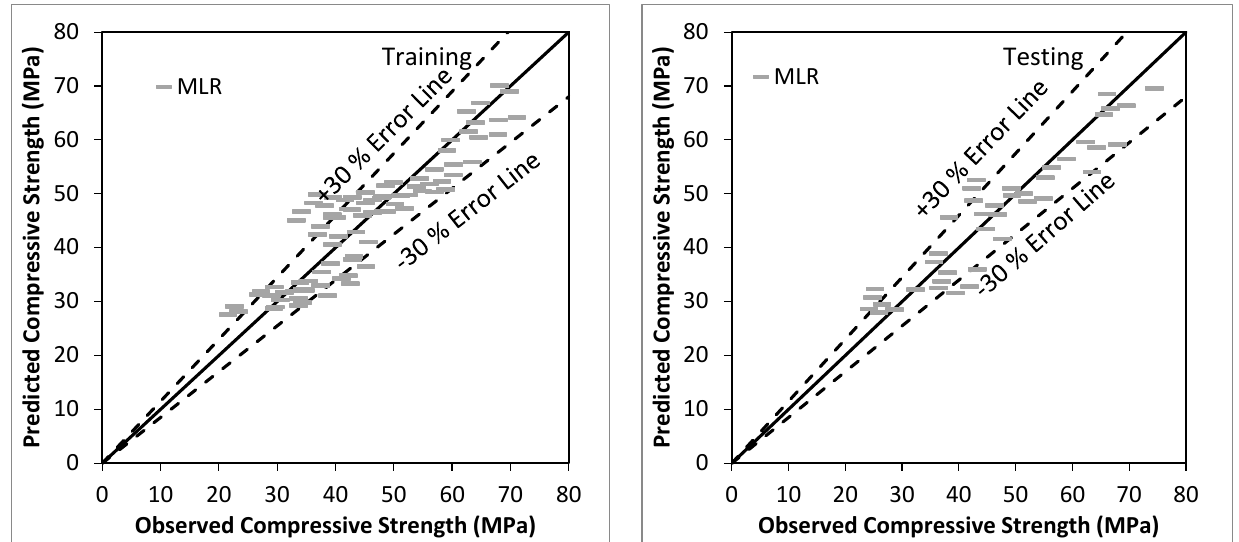
Figure 1. Observed vs. Predicted values using MLR based model using training and testing stage.